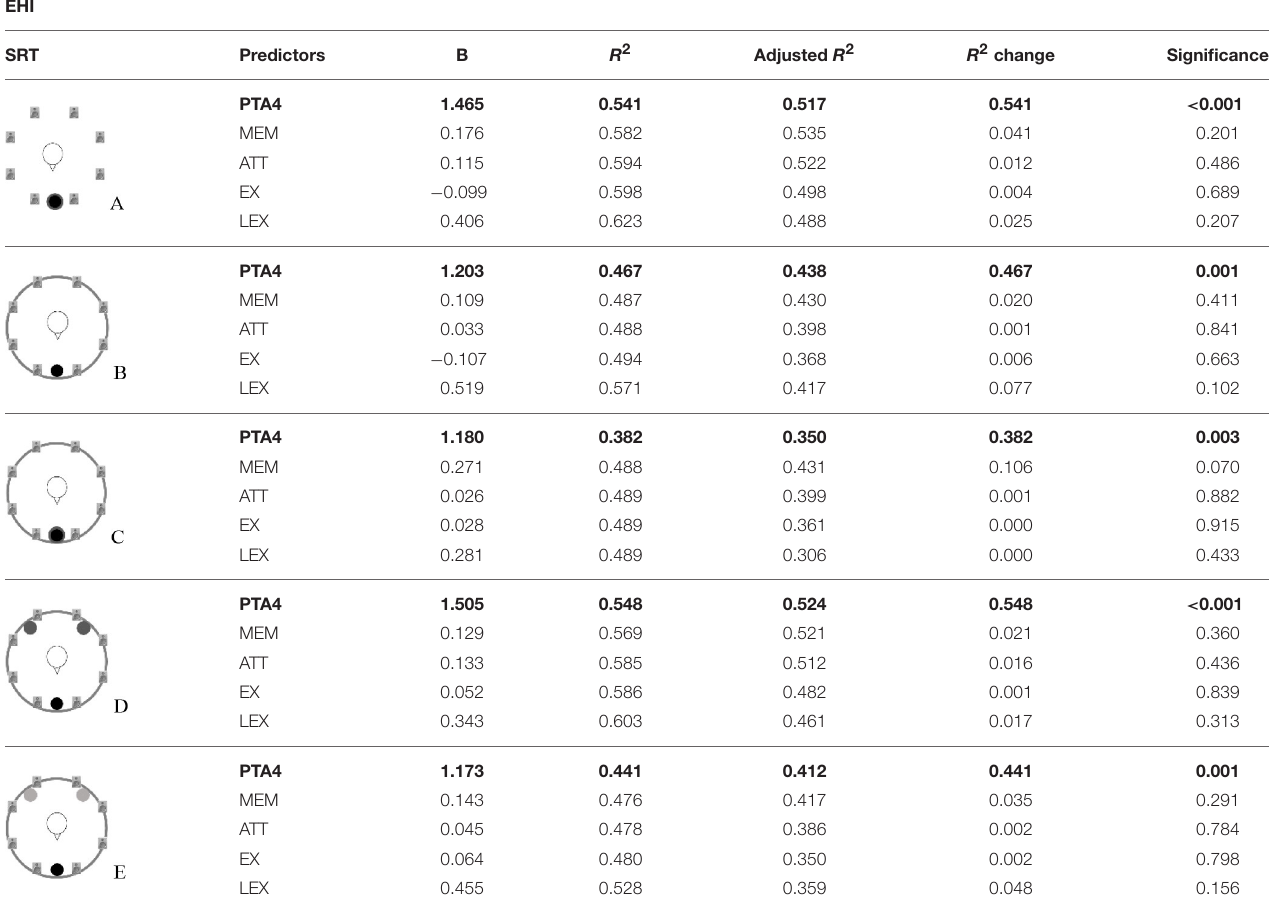
TABLE 6 | Results of the stepwise regression analyses for the data of the EHI group ( N = 21) calculated for each listening condition (A–E). EHI SRT Predictors Significance